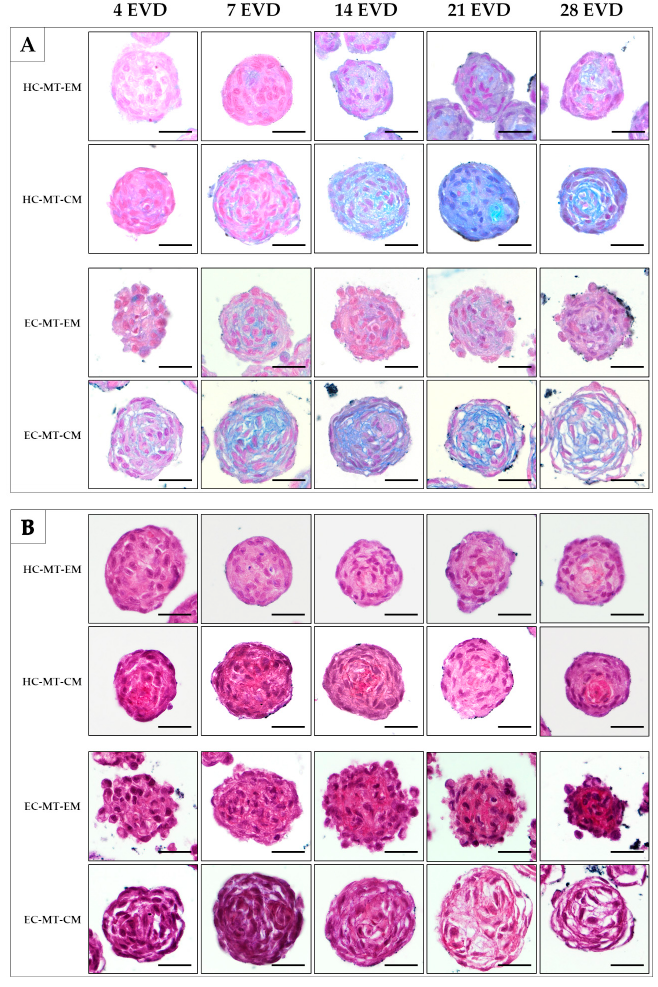
Figure 7. Histological and histochemical analyses of HC-MTs and EC-MTs under CM and EM. Alcian blue (AB) stains acid proteoglycans in light blue ( A ). Picrosirius (PS) stains the fibrillar collagen fibers in red ( B ). Note that CM-MTs show higher AB staining than EM-MTs ( A ). For all pictures, scale bar = 50 µm.